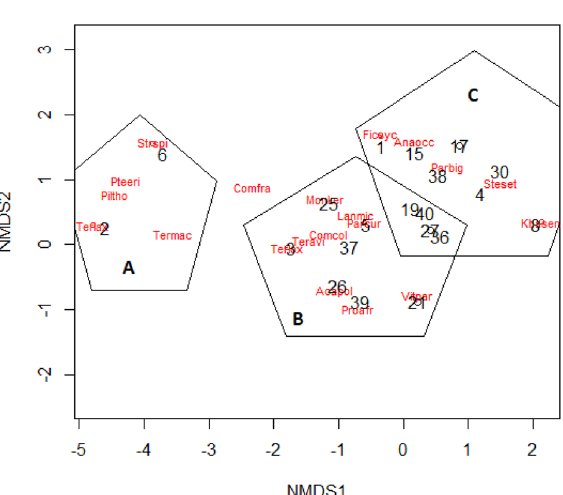
Figure 3. Nonmetric dimensional scaling analysis showing the dissimilarity between agroforestry systems and their surrounding natural vegetation. NMDS identified three plant communities ( A – C ). Numbers represent plots from adjacent natural vegetation (1–8) or from agroforestry systems (8–40). The words in red represent the plant species. Termac = Terminalia macroptera , Pteeri = Pterocarpus erinaceus , Piltho = Piliostigma